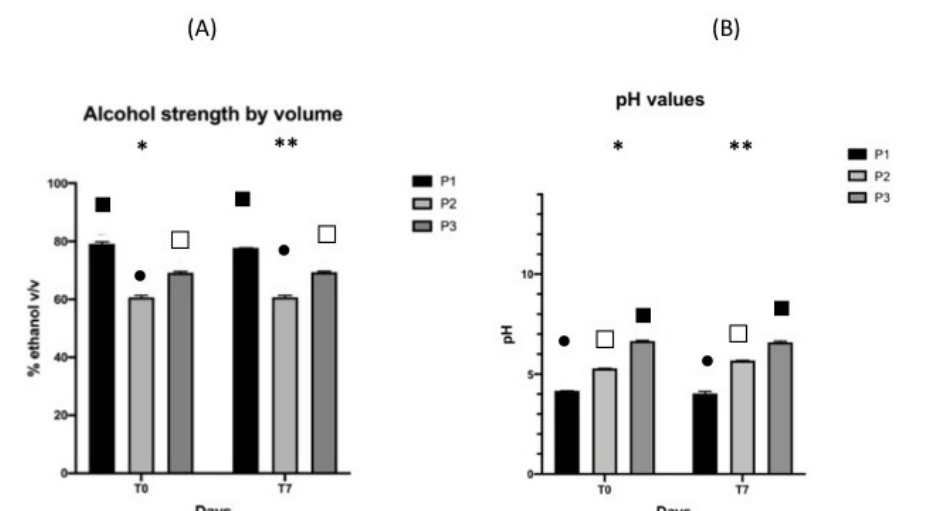
Figure 2. Alcohol strength by volume (A) and pH (B) before and after 7 days of cold storage at 0 ± 2 °C. Values are expressed as the mean (±SD) of sample replicates ( n = 3). ( ∗ ) and ( ∗∗ ) indicate the difference among the products at the two endpoints, T0 and T7 respectively. Different symbols indicate the differences among the values in the three products ( p ≤ 0.05).